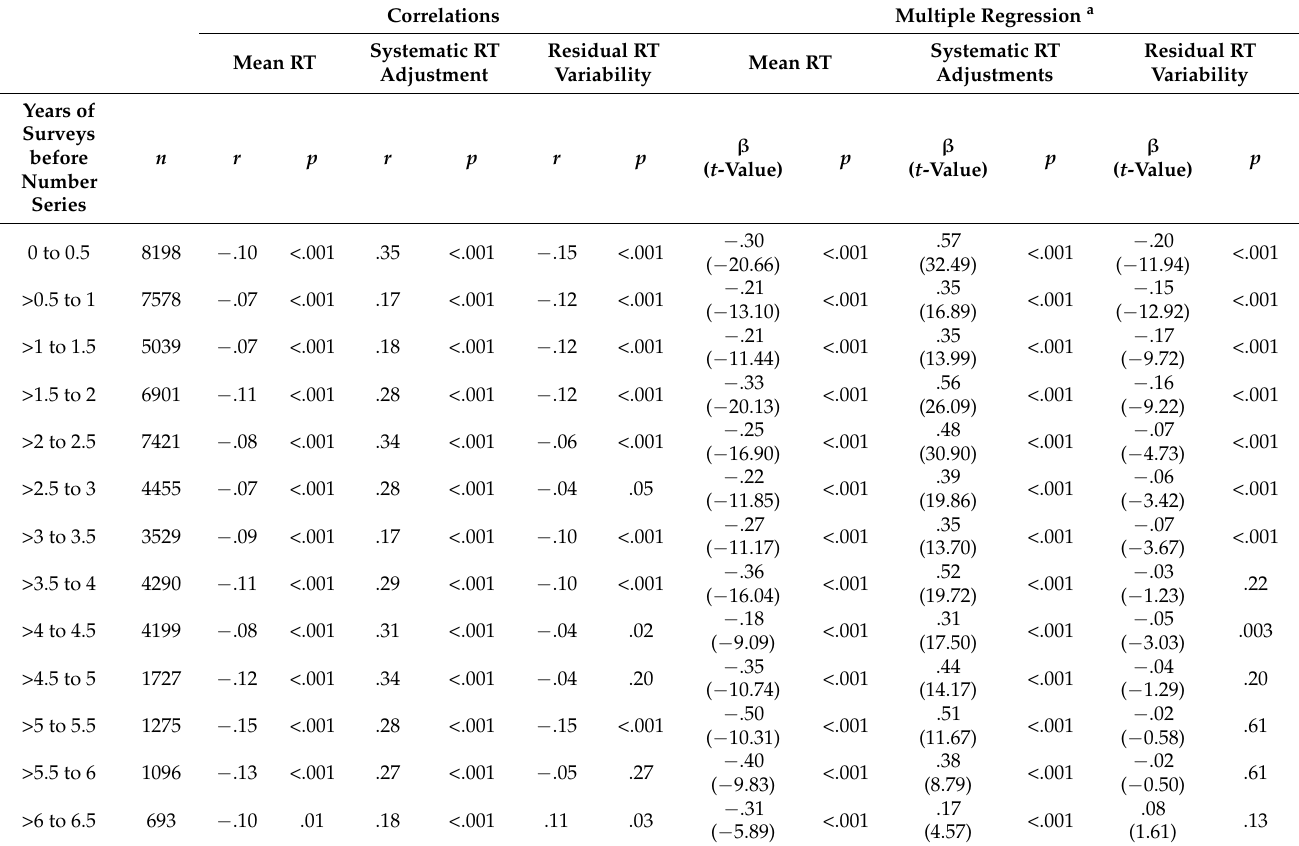
Table 6. Results for response time components as predictors of number series scores by time lag between surveys and cognitive